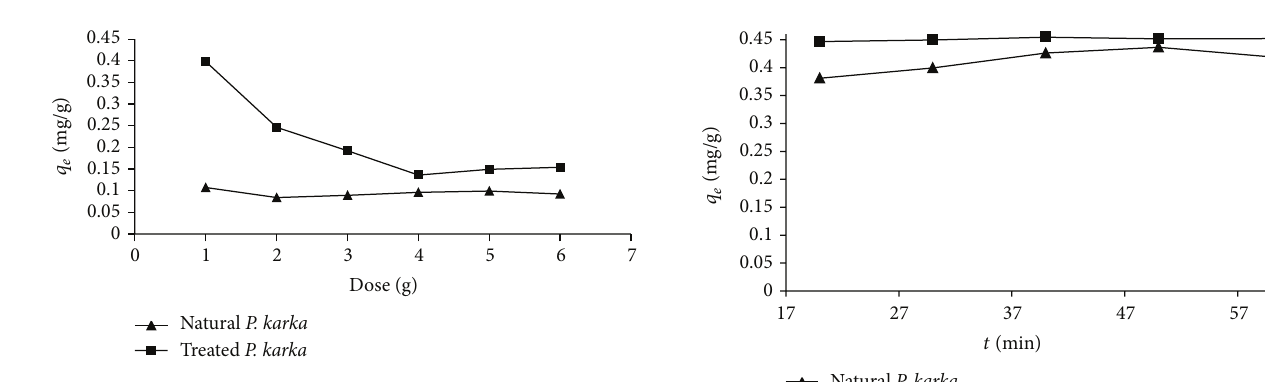
Figure5:Effectofbiosorbentdoseonadsorptioncapacityofnatural P. karka and treated P. karka (concentration = 10 mg/L, time = 30 minutes, 𝑇 = 298 K, agitation speed = 150 and 100rpm natural P. Figure 6: Effect of contact time on adsorption capacity of natural P. karka and treated P. karka (concentration = 10mg/L, time = 20– 60 minutes, 𝑇 = 298 K, agitation speed = 150 and 100rpm natural P. karka and treated p. karka , resp., dose of biosorbent = 1 g/100mL, and pH = 6 and 7 for natural P. karka and treated p. karka ,